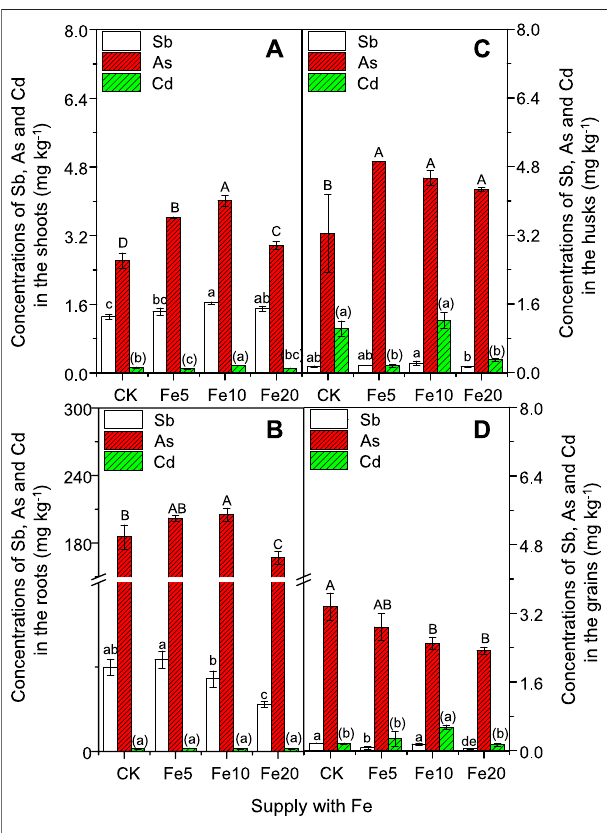
FIGURE 4 | Effects of FeCl 3 on the concentrations of Sb, As, and Cd in the shoots, roots, husks, and grains. Bars aremeansand standarddeviations for three replications. Different lowercase letters, capital letters and parenthesized letters denote signi fi cant differences (at p ≤ 0.05) for Sb, As, and Cd concentrationsin the shoots, roots, husks and grains among different treatments,